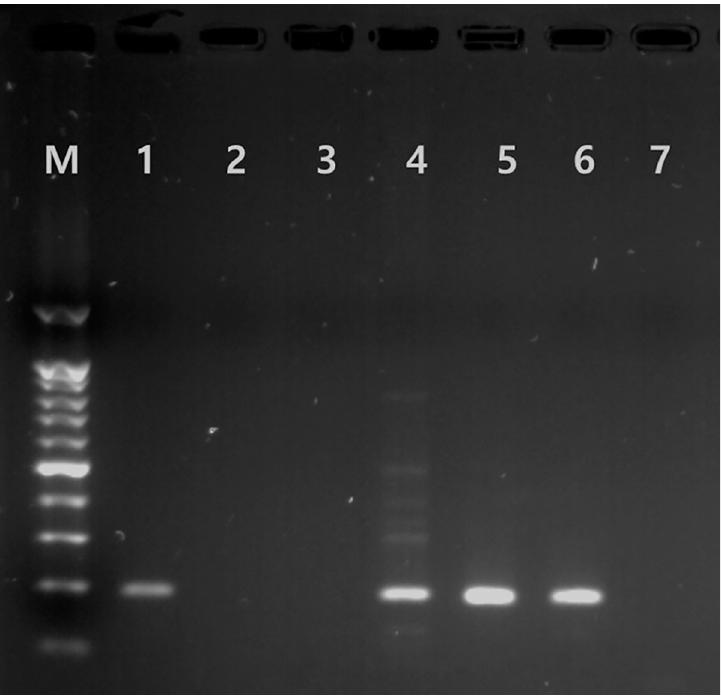
Fig 1. Detection of Sarcoptes scabiei DNA by polymerase chain reaction (PCR). DNA was purified from skin scraping samples from suspected scabies patients (lanes 1–5), and run by electrophoresis with a positive control (lane 6), and a negative control (lane 7). Lane M is a 100-bp DNA ladder marker. The median age of the patients at the time of diagnosis in the 30 scabies patients was 60 ± 17 years (95% CI = 54–67) and 57% were male. Thirteen of these patients (43%) had a history of hospitalizations and 10 (33%) had a history of hospital visits associated with family or friends. Seven patients (23%) were bedridden resulting from other debilitating medical conditions and 1 patient (3%) did not bring the itching symptoms to the physician’s attention due to other previously diagnosed neurological diseases. Overall, the median time from symptoms onset to diagnosis of scabies was 77 days (95% CI = 47–107). The most common skin manifestation was papules in 23 patients (77%), followed by nodules in 2 (7%) and excoriated patches in 2 (7%). There was no case reported of crusted scabies. The torso was the most common location in 27 patients (90%), followed by the extremities in 22 (73%), and the genitalia in 7 (23%) of the patients. Approximately 43% of patients with scabies had the skin lesion in the hands (S1 Fig). The diagnostic performances of PCR and microscopy are shown in Table 1. The sensitivity of the microscopic examination was 100% (95% CI = 85–100; 22/22), 92% (95% CI = 73–99; 22/24), and 73% (95% CI = 54–88; 22/30) in confirmed scabies; confirmed and clinical scabies; and confirmed, clinical, and suspected scabies, respectively ( p = 0.006). As the level of diagnos- tic certainty decreased, the sensitivity of microscopy decreased. The microscopic examination specificity was 100% (95% CI = 80–100; 17/17). The sensitivity of the scabies PCR test was 86% (95% CI = 65–97; 19/22), 83% (95% CI = 63–95; 20/24), and 80% (95% CI = 61–92; 24/30) in confirmed scabies; confirmed and clinical scabies; and confirmed, clinical, and suspected sca- bies, respectively ( p = 0.59). As the level of diagnostic certainty decreased, the sensitivity of the scabies PCR also decreased, but there was no statistically significant difference between the